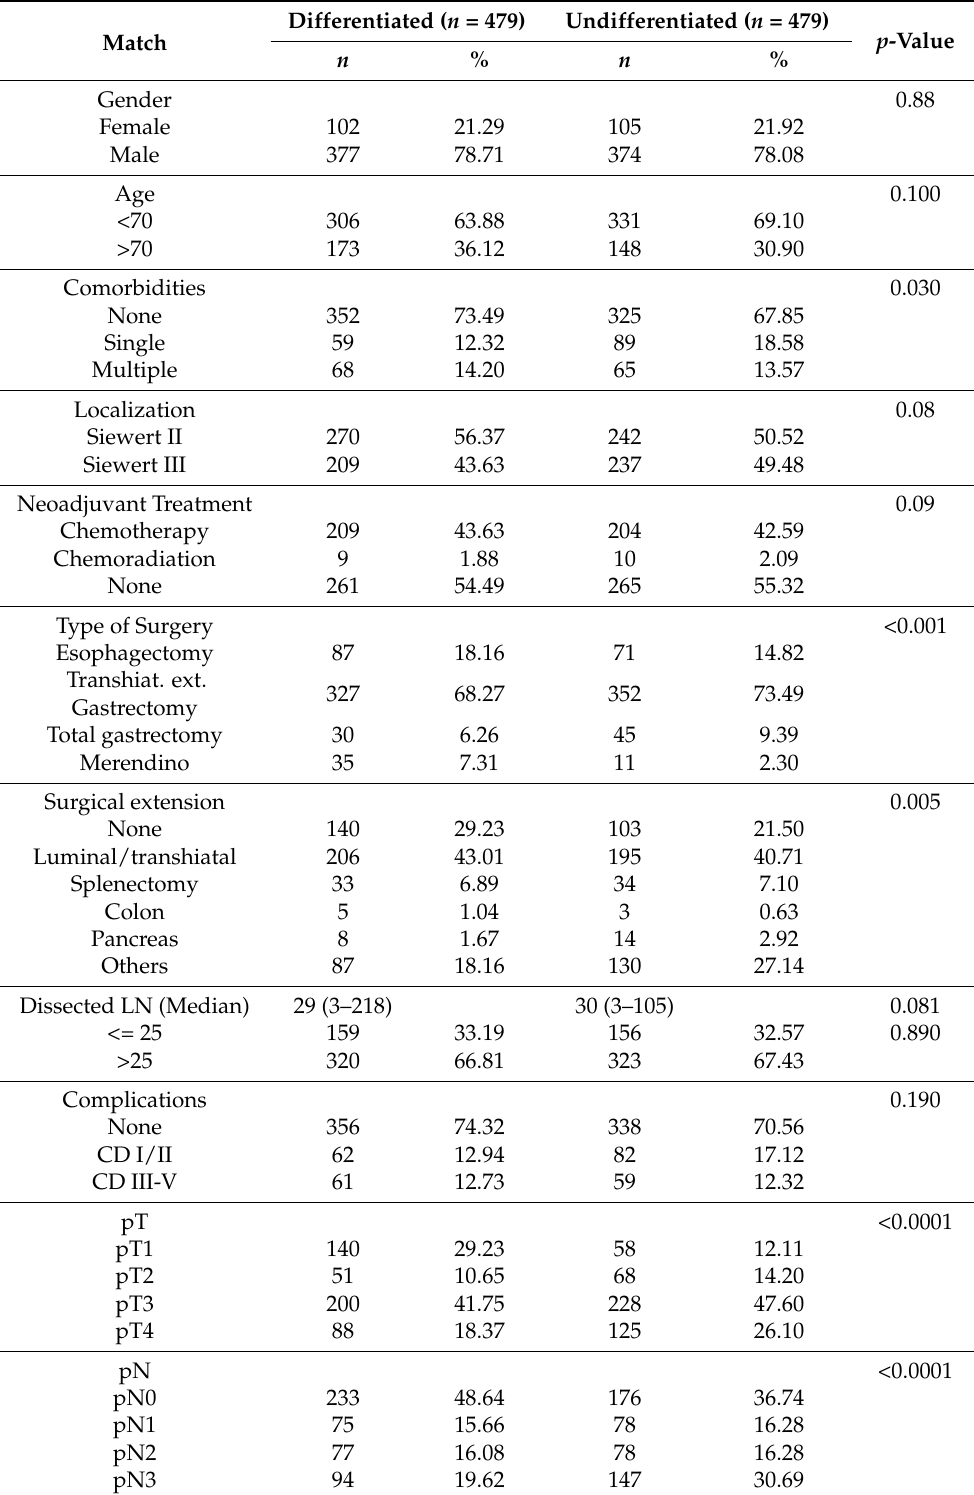
Table 4. Baseline characteristics for patients with differentiated/undifferentiated histotypes after